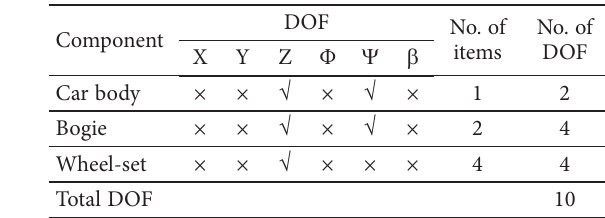
Table 1. The degrees of freedom in the vertical random vibration